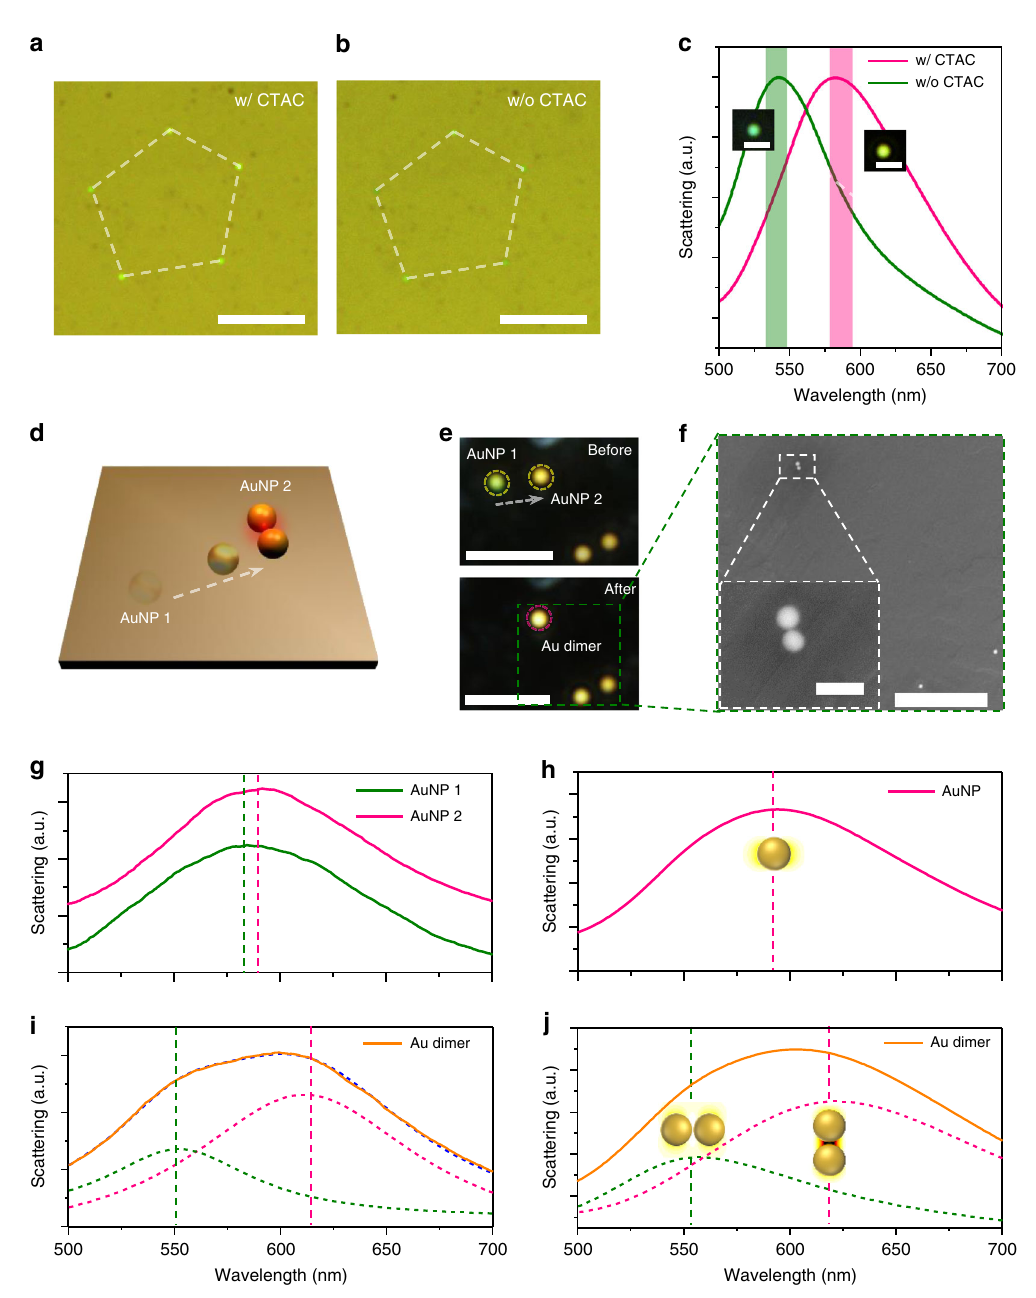
Fig. 5 In situ optical spectroscopy. a , b Optical images of a pentagon pattern composed of fi ve 100 nm AuNPs a before and b after the removal of CTAC. Two identical white dashed pentagons are added to help indicate the positions of AuNPs. c The scattering spectra of 100 nm AuNPs measured before and after the removal of CTAC. The shaded area indicates the standard deviation of the peak position. The insets show the corresponding dark- fi eld images. d Schematic illustration of the assembly of Au dimer with two 100 nm AuNPs. e Dark- fi eld images of the AuNP before and after the dimer assembly. f SEM image of the Au dimer. g Scattering spectra of the two AuNPs before assembly. h The simulated scattering spectra of a 100 nm AuNP. i Scattering spectra of the Au dimer. The pink and olive dashed curves represent the longitudinal and transverse plasmon modes, respectively. j The simulated scattering spectrum of the AuNP dimer. The insets in h , j show the corresponding electric fi eld enhancement pro fi les. Scale bars: a , b 10 μ m; inset in c 2 μ m; e 5 μ m; f 2 μ m; inset in f 200